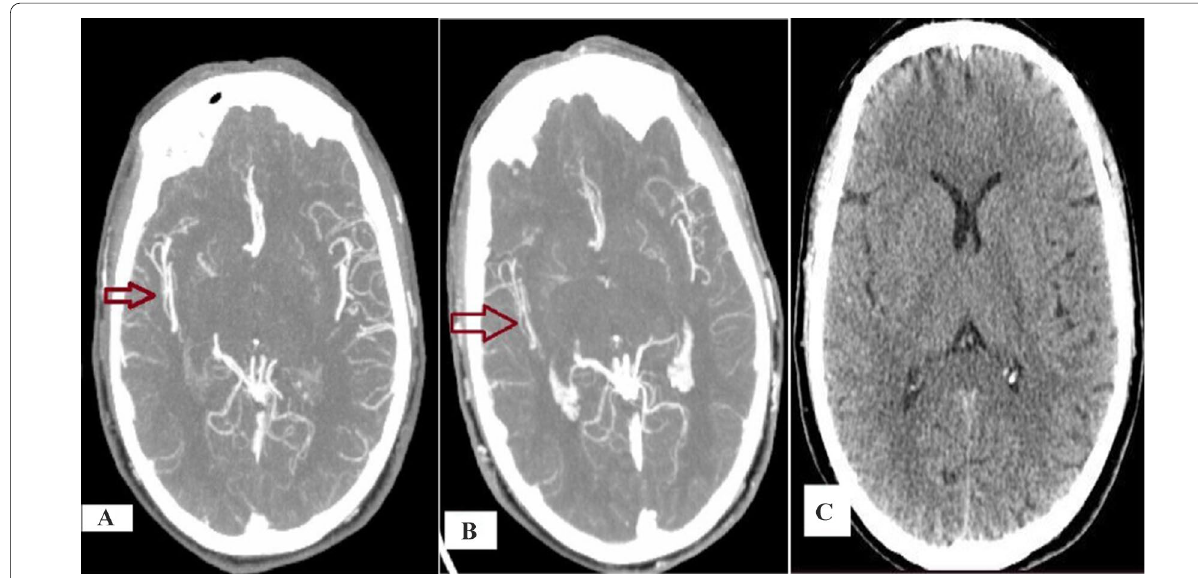
Fig. 5 Patient with pre-tPA NIHSS